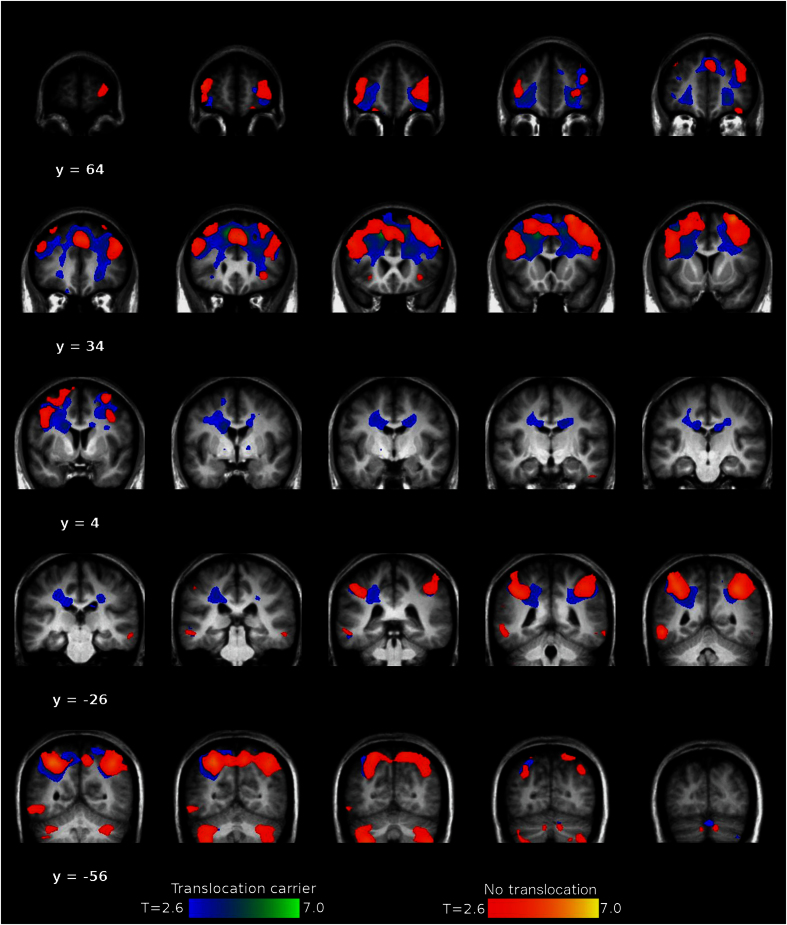
Effect of increasing working memory load on blood oxygen level-dependent activity measures in translocation carriers and non-carriers. Coronal sections through the brain to show the effects of increasing working memory load (from 0- to 1- to 2-back) in the N-back task on functional MRI in t(1;11) translocation carriers and non-carriers. The image is thresholded at P<0.001, uncorrected, to show regional activations. These were statistically significant in/across both groups in bilateral inferior, middle, and superior frontal cortices, bilateral inferior parietal lobules, right cerebellum, left inferior temporal gyrus, and the left middle orbital gyrus at P<0.05, family-wise error corrected for multiple comparisons. There were no statistically significant group differences at a family-wise error-corrected threshold of P<0.05.